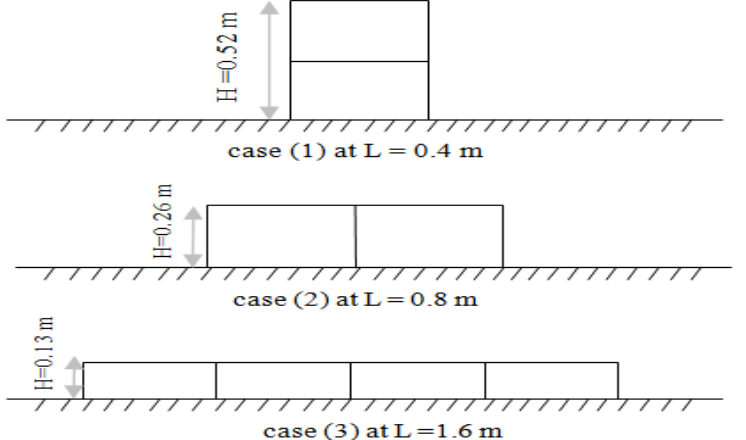
Figure 10. Sectional elevation in the canal where the biofilter was installed with a constant volume with variable length and height. Table 6. The measured water depths upstream and downstream of the biofilter and the resulting relative heading up (h 1 /h 2 ) for a constant volume and variable length and height.